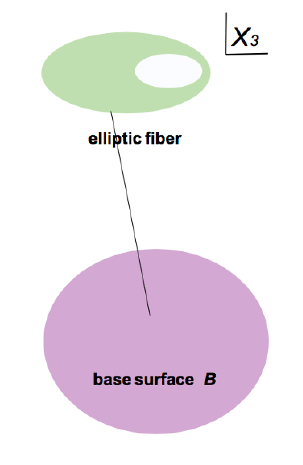
Figure 1. Elliptic (cid:12)bration of the Calabi-Yau threefold X 3 . The (cid:12)ber may degenerate at the locus where the discriminant (cid:1) of the Weierstrass equation